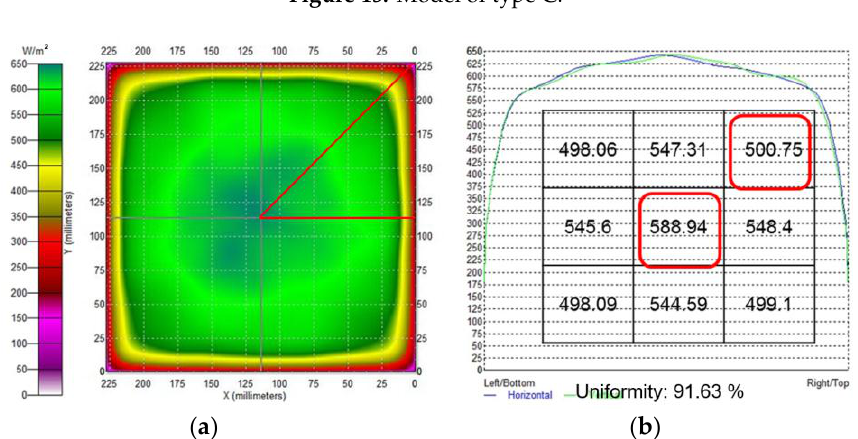
Figure 16. Simulation results of type C: ( a ) Results of type C, ( b ) Uniformity of type C.